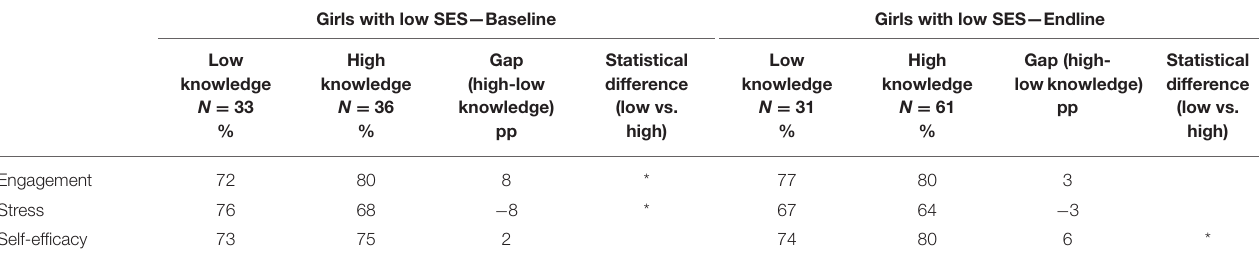
Girls with low SES—Baseline Girls with low SES—Endline